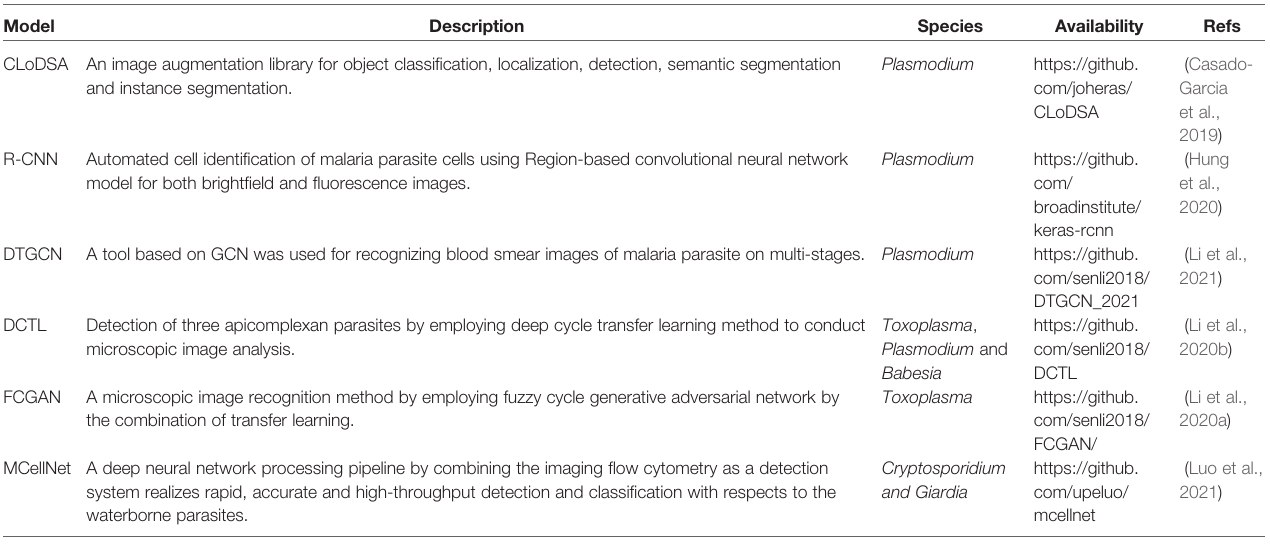
TABLE 3 | Available tools for microscopic image recognition and detection of protozoal pathogens.